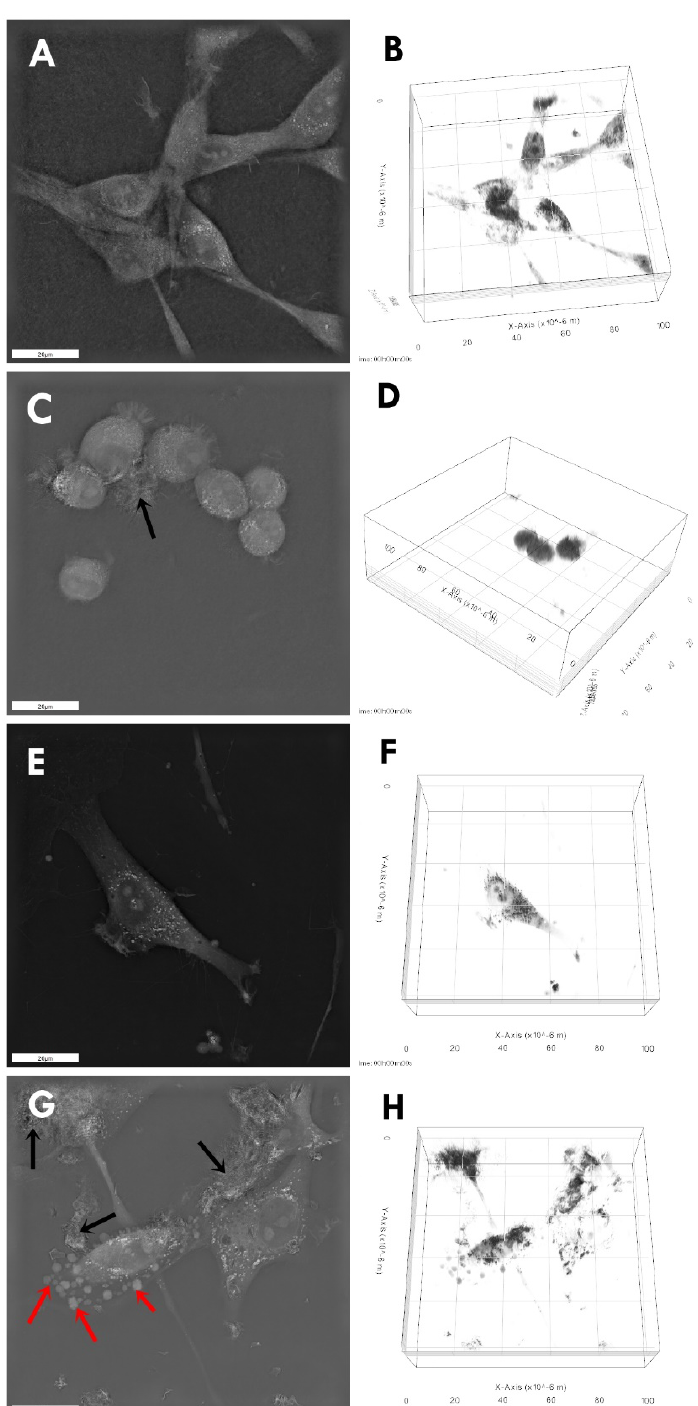
Figure 3. Morphology of U87 ( A – D ) and HS-5 ( E – H ) cells: untreated control ( A , B , E , F ), treated with pristine graphene ( C , D , G , H ). Notes: Black arrows point to graphene agglomerates. Red arrows point to apoptotic bodies.